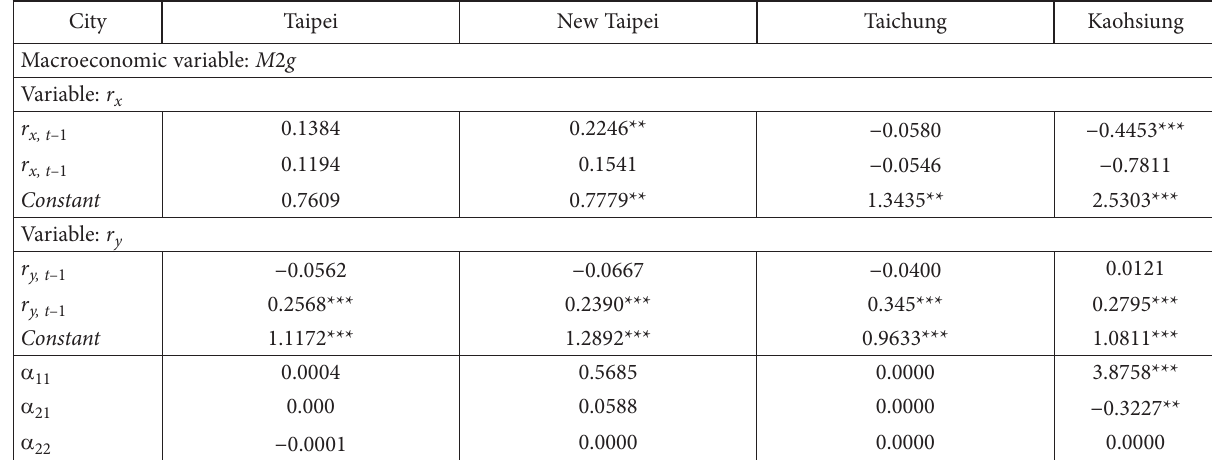
Table 7. VAR-GARCH models of money supply and the housing